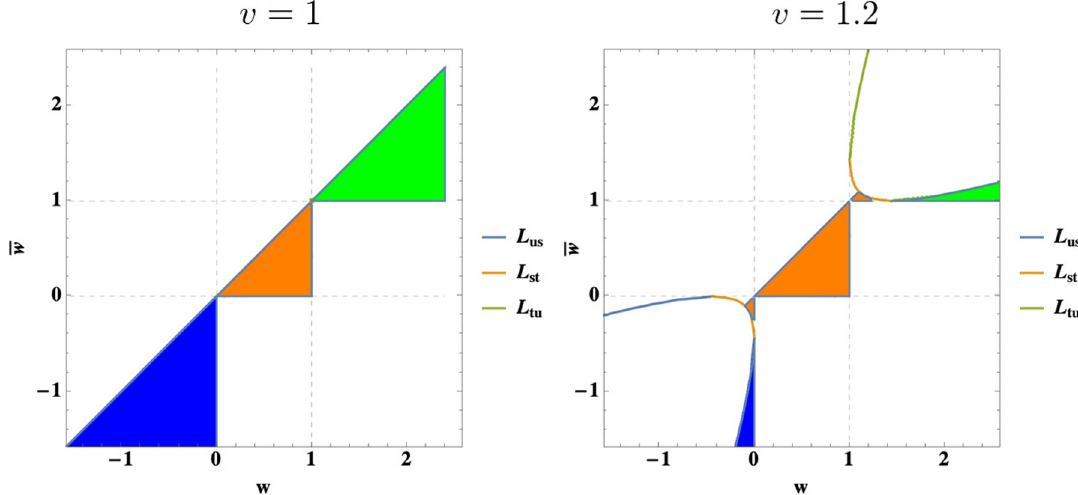
Figure 3 . The dispersive transform integration region correspond to the area under the curve where we have illustrated the three Lorentzian regions L L tu = w, w > 1 for w < w . The left panel corresponds to v = 1 while the right panel corresponds to v = 1 . 2 . The domain of integration lies within the blue ( L